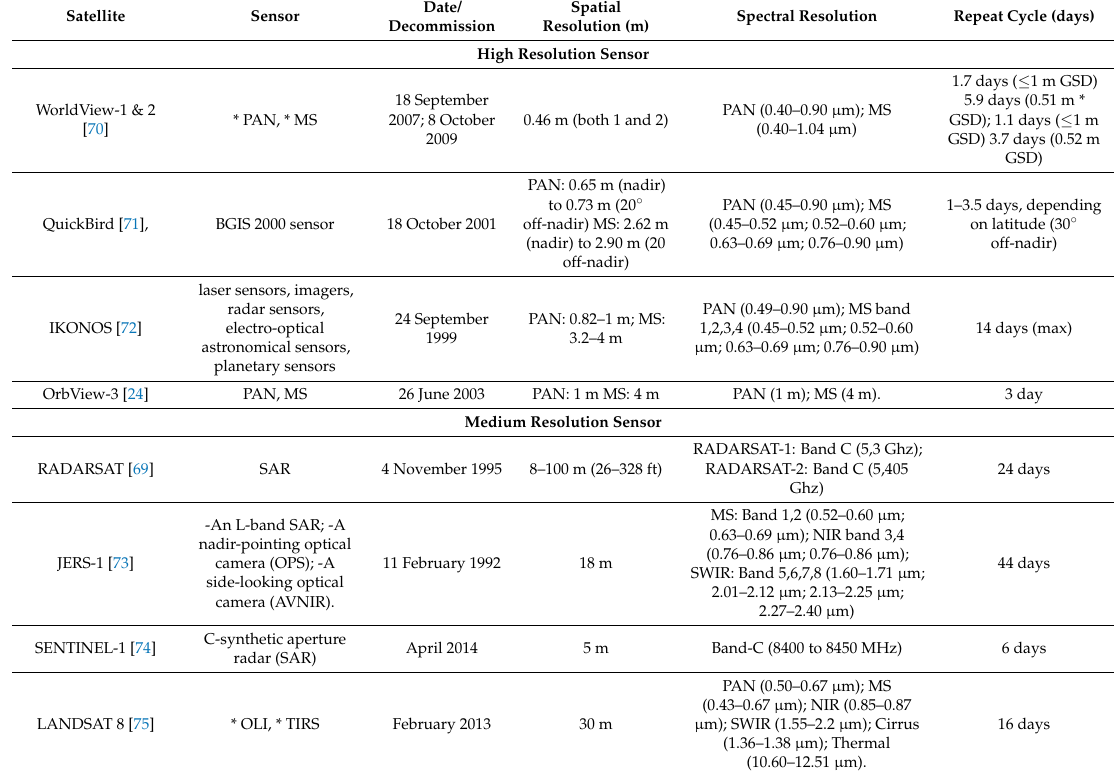
Table 3. Remote sensors used in past studies on CW resilience under